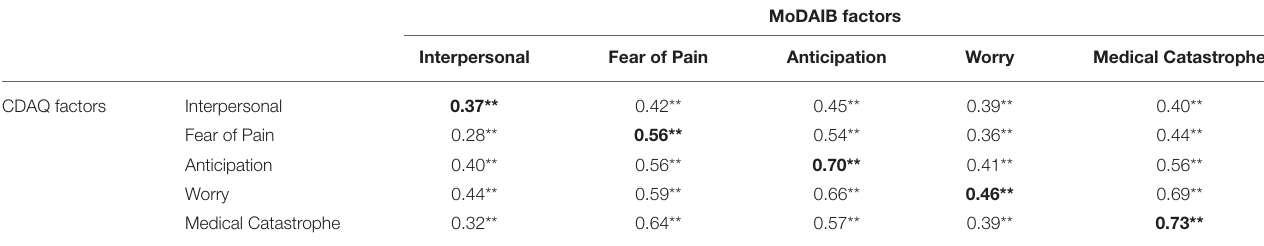
TABLE 5 | Correlations between MoDAIB and CDAQ factors. MoDAIB factors Interpersonal Fear of Pain Anticipation Worry Medical Catastrophe CDAQ factors